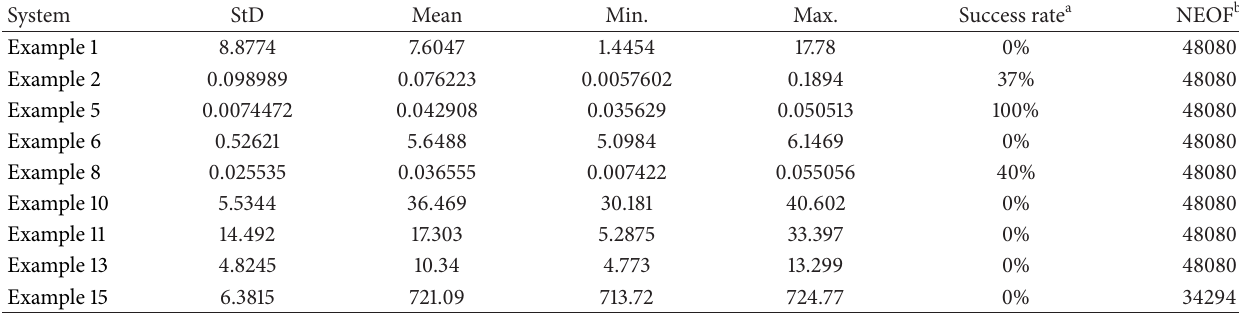
Table 4: Simulation for fractional-order systems by Genetic